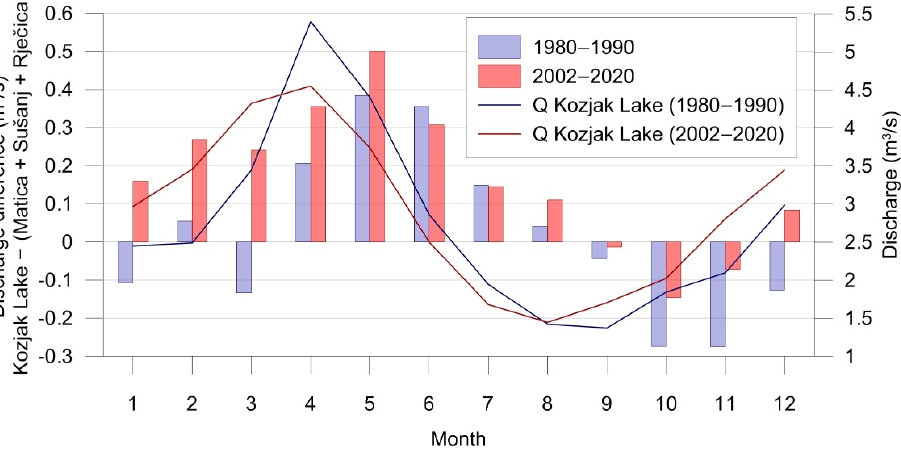
Figure 9. Difference of mean monthly discharges for Kozjak Lake (= Kozjak Lake – (Matica + Sušanj + Rje č ica)) for two periods, 1980–1990 and 2002–2020.